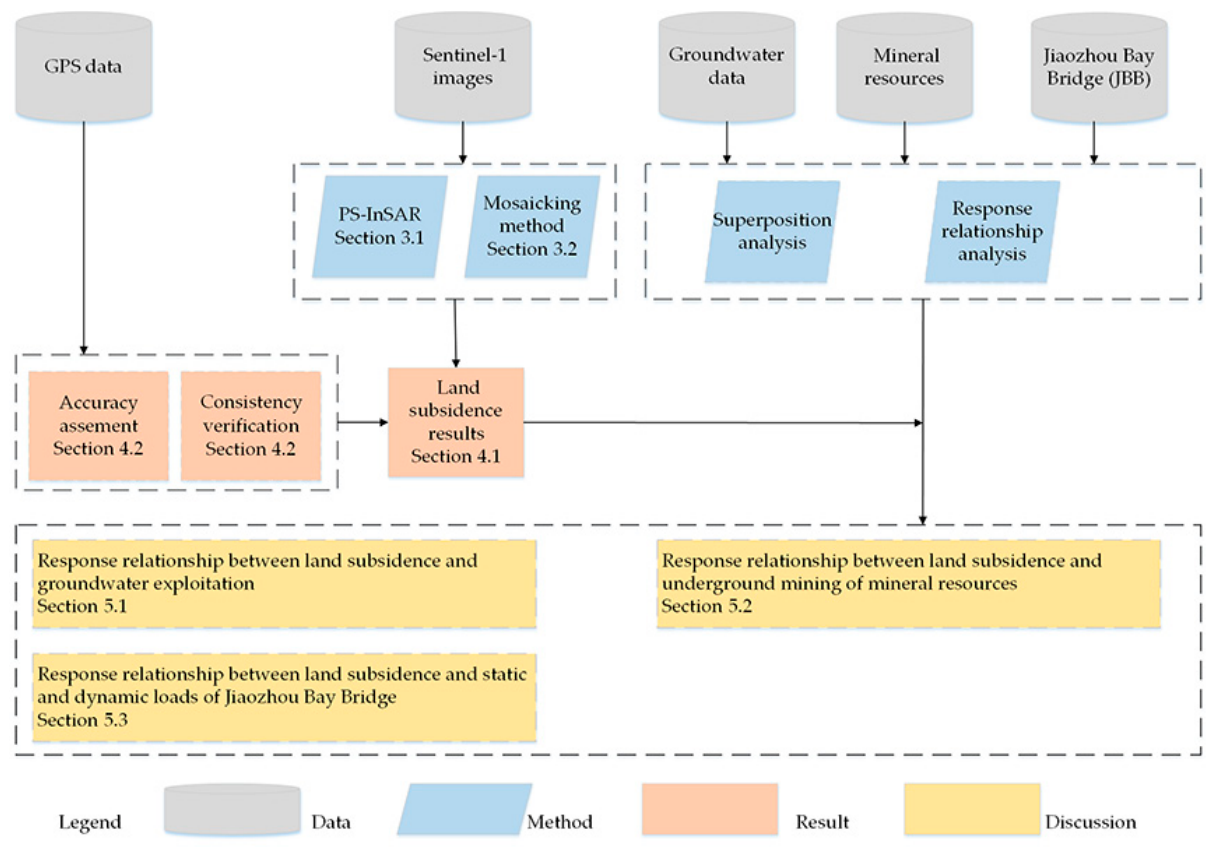
Figure 2. A flowchart of this